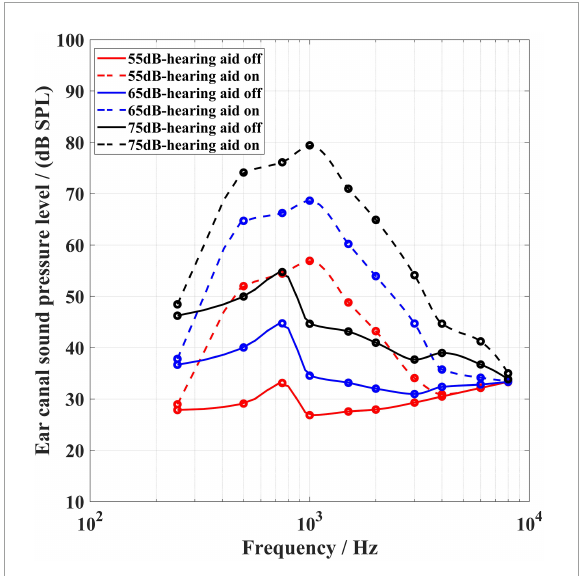
FIGURE10 Results of the ear canal sound pressure level (SPL) measurement in one subject. The solid lines show the ear canal SPL is measured by the probe microphone with the loudspeaker turned on and the BC hearing aid turned off, while the dashed lines indicate the ear canal SPL is measured by the probe microphone with the loudspeaker turned on and the BC transducer of the hearing aid playing the aided signal. The red, blue, and black lines indicate the stimulation inputs with an overall SPL of 55, 65, and 75 dB, respectively.